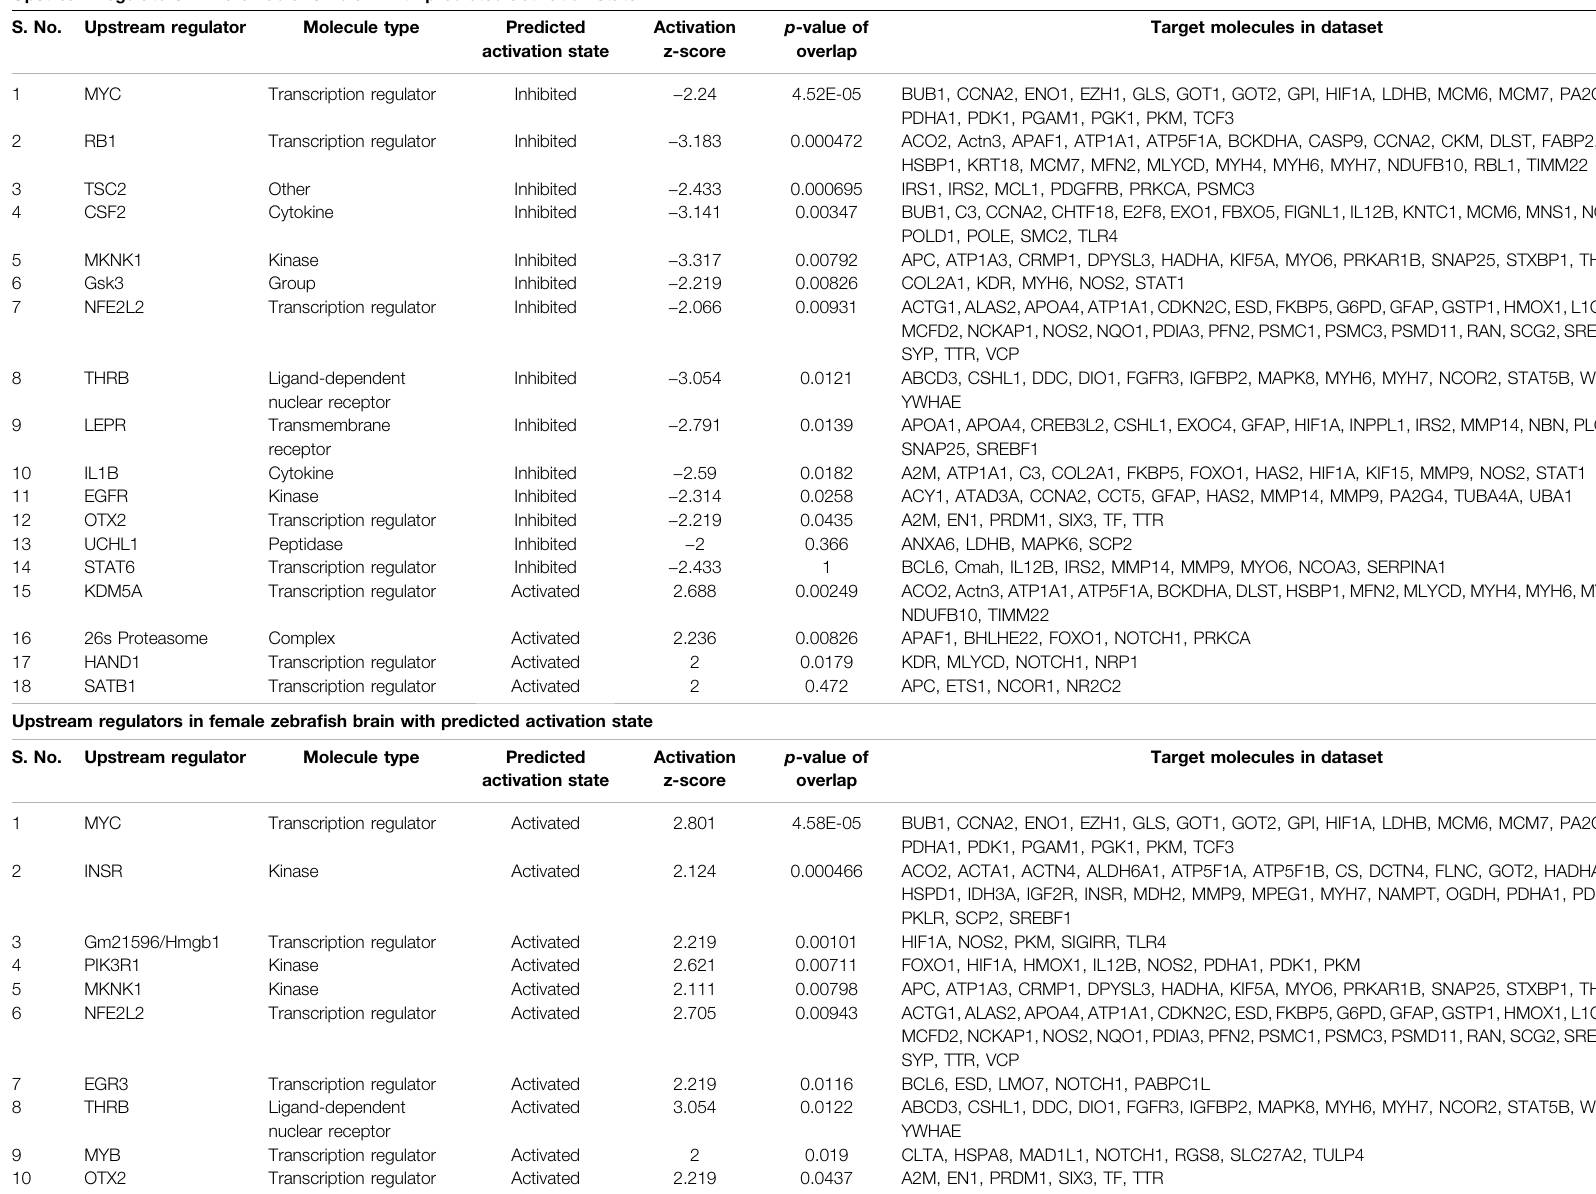
TABLE 2 | IPA generated upstream regulators analysis for male and female zebra fi sh brain proteome induced by hypoxia following recovery. Upstream regulators in male zebra fi sh brain with predicted activation